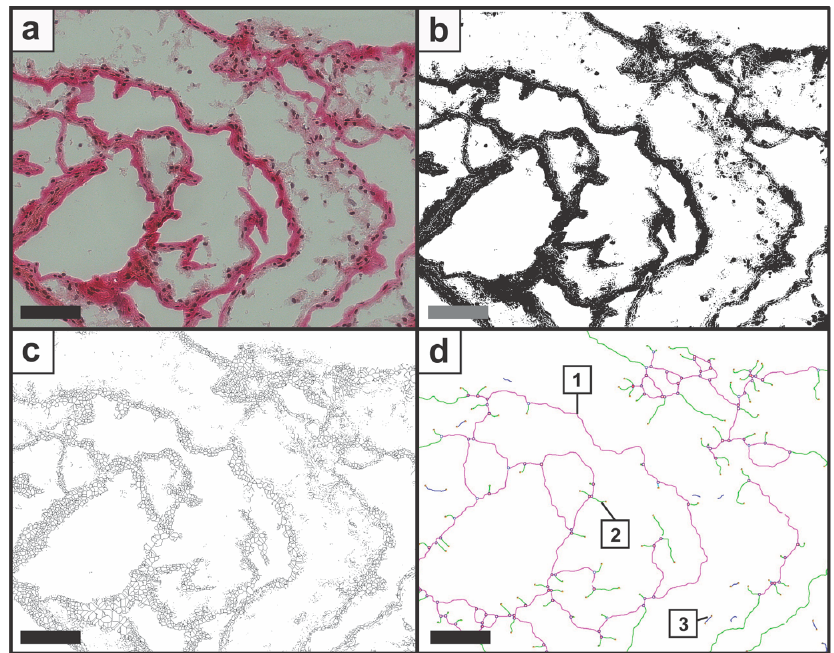
Figure 2. Image processing is demonstrated with ( a ) original image; ( b ) the binary image; ( c ) the skeleton image; and ( d ) the structure analysis with the output image. The plug-in Angiogenesis Analyzer processed the one-line-wide structure according to the pre-defined elements, and Nd.Nd were displayed in purple (1), Nd.Tm in green (2), and Tm.Tm (3) in blue. The candidate section was mechanically compressed with a compression rate of 40%. Scale bars represent 100 µm.